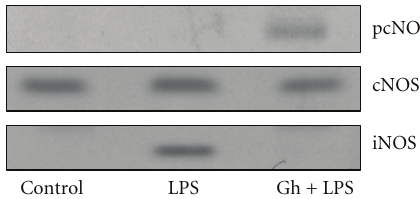
Figure 6: E ff ect of ghrelin on P. gingivalis LPS-induced changes in the expression of iNOS protein and cNOS phosphorylation in the acinar cells. The cells were treated with the LPS at 100ng/mL or ghrelin (Gh) at 0.6 μ g/mL + LPS and incubated for 16h. Cell lysates were resolved on SDS-PAGE, transferred to nitrocellulose, and probed with anti-iNOS antibody or phosphorylation-specific cNOS (pcNOS) antibody, and after stripping reprobed with anti- cNOS antibody. The immunoblots shown are representative of three experiments.